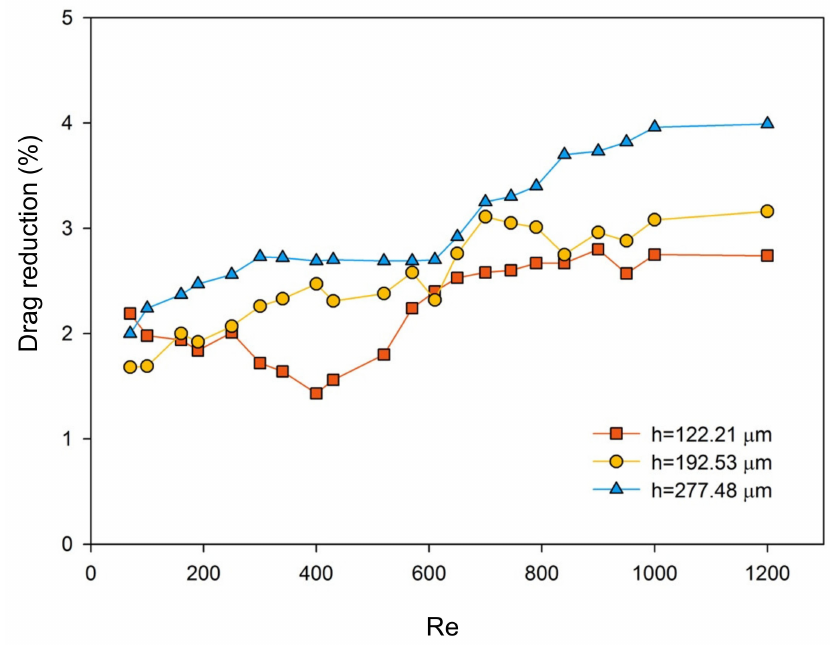
Figure 10. Cu 2 + / HNO 3 -etched zinc + fluoropolyurethane drag reduction rate at di ff erent channel heights and Reynolds